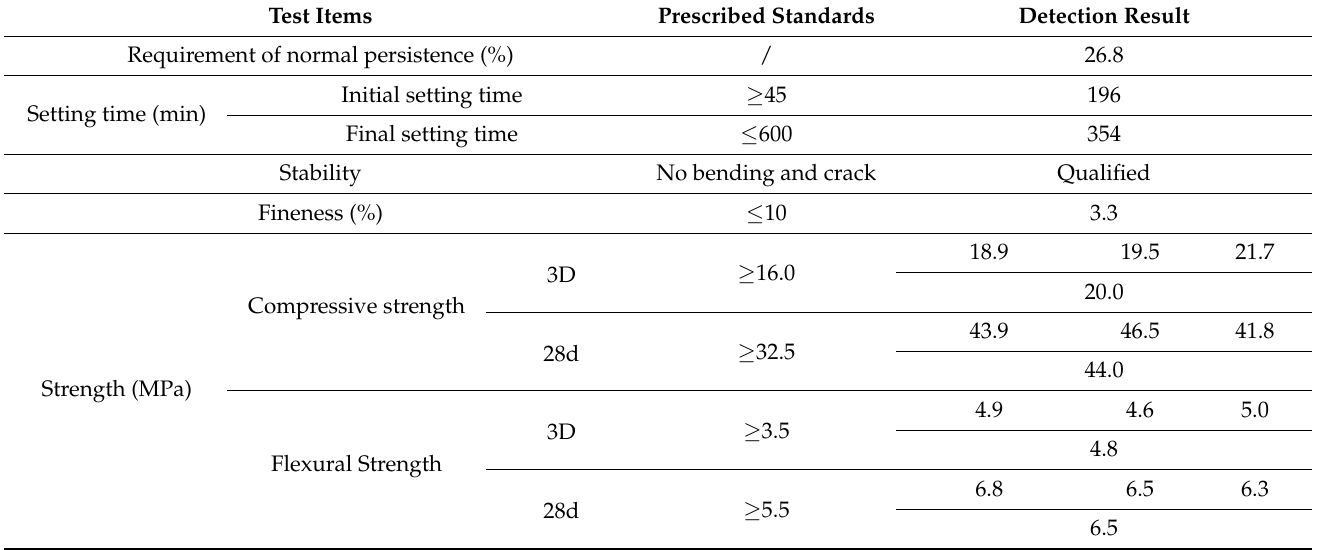
Table 1. P.042.5 Basic performance indexes of ordinary Portland cement.